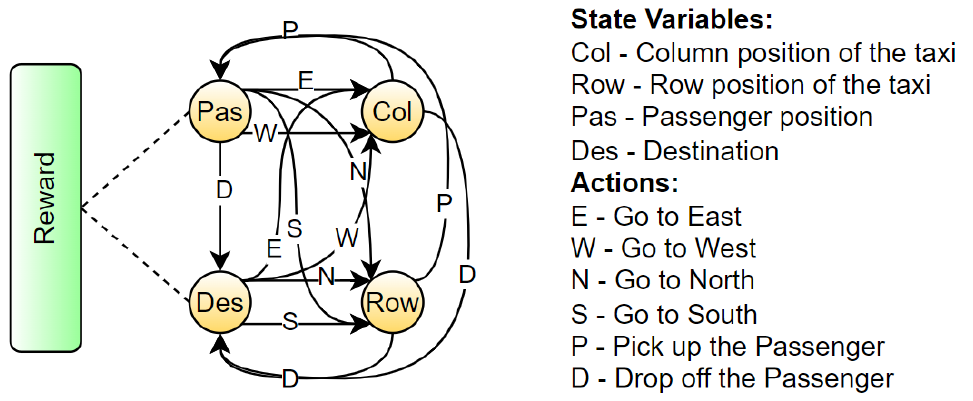
Figure 16. Action-Influence graph for the Taxi